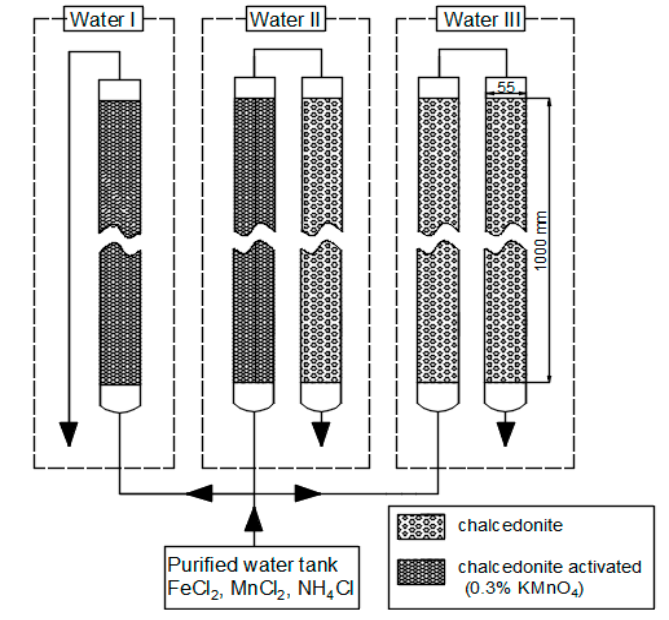
Figure 1. Scheme of the test stand. Table 1. Parameters of the model filters. Table 2. List of reagents used in the research.